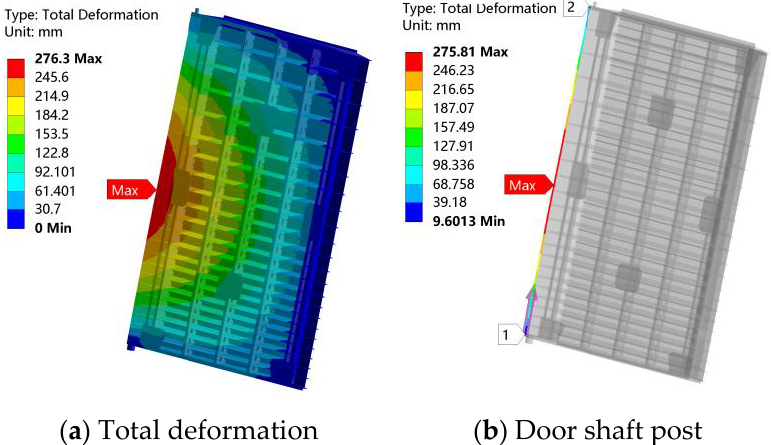
Figure 11. ( a ) Deformation of the overall body, ( b ) Deformation of the door shaft column of the backless tie rod gate in a static state.